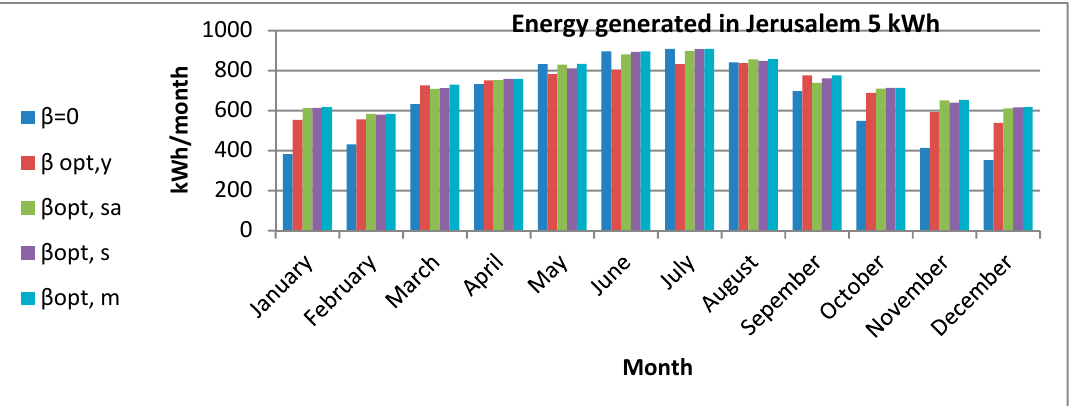
Figure 11. Monthly energy generated in Jerusalem by a 5 kWh system.